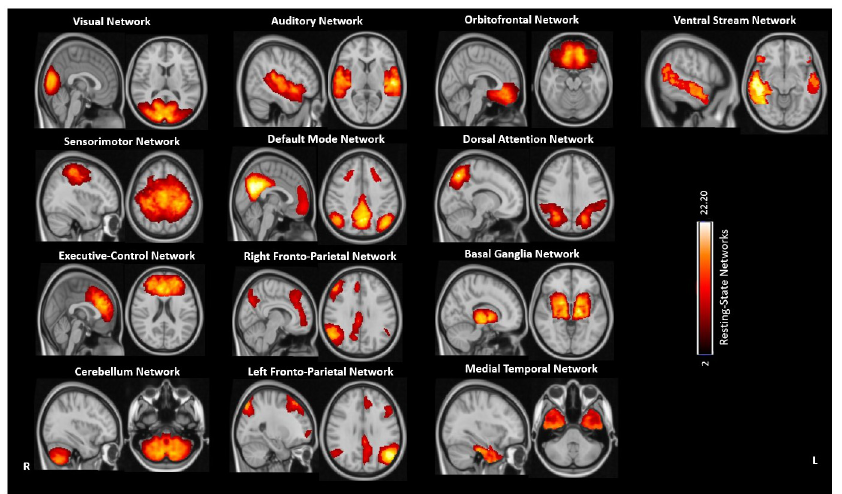
Fig 1. Resting state networks (RSNs) extracted from the whole group of participants using the Melodic—Group ICA approach. The color bar represents the range of intensity voxels. Brain maps are shown in radiological